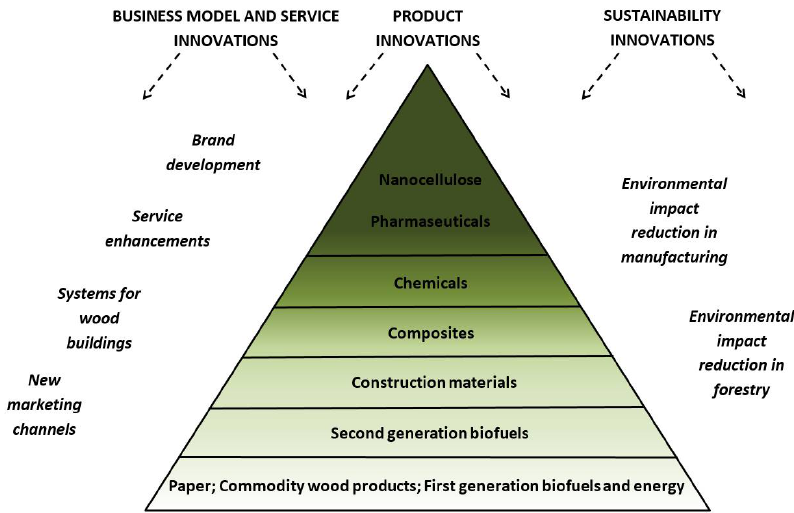
Figure 1. Classification of forest bioeconomy-related innovations using a value pyramid. Note: Due to condensing of the text, the full content of the lowest part includes pulp, paper, paperboard, commodity wood products, and first-generation biofuels and bio-based energy.